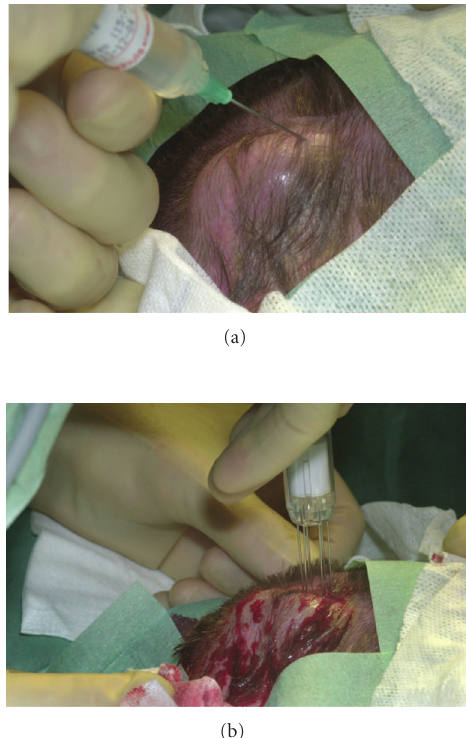
Figure 6: (a) Intralesional injection of bleomycin. (b) Electropora- tion therapy.